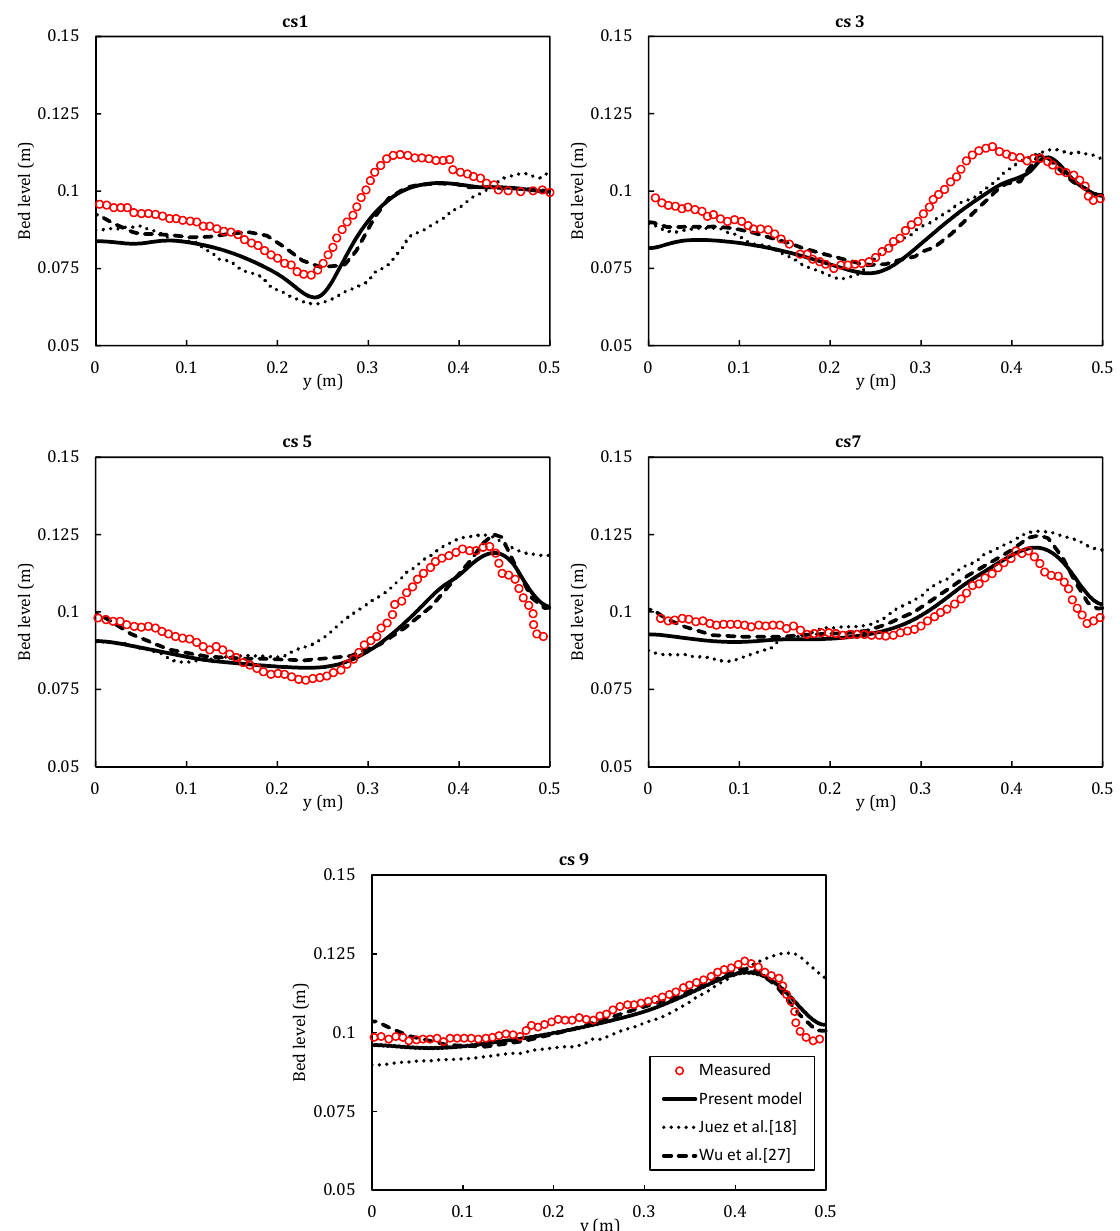
Figure 12. The measured and calculated bed elevation at cross section cs1, cs3, cs5, cs7 and